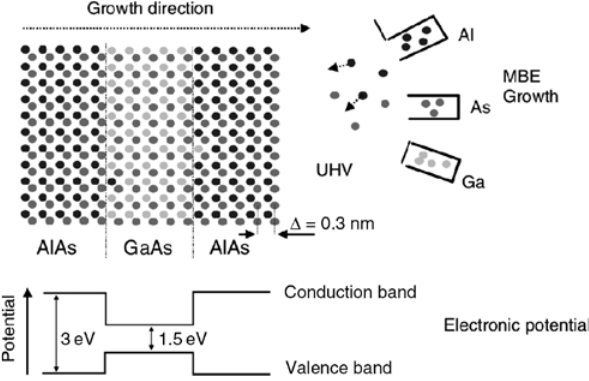
Figure 1: Representation of molecular beam epitaxy growth (MBE) of a GaAs/AlAs structure, together with the related electronic potential.